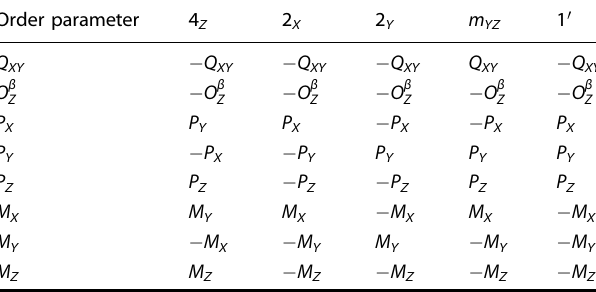
Fig. 7 Conceptual illustration of cross-control of magnetic quadrupole and octupole. a In the case of a hypothetical achiral structure, the antiferromagnetic phase of Pb(TiO)Cu 4 (PO 4 ) 4 would possess only magnetic quadrupoles Q XY . + and − represent the signs of Q XY . The control of the sign of Q XY requires a simultaneous application of electric fi eld E Y and magnetic fi eld H X ( E Y H X ). b , c By introducing the chirality of the crystal structure, which corresponds to the actual structure of Pb(TiO)Cu 4 (PO 4 ) 4 , the magnetic structure acquires additional octupole moments O β . Here, a pair of chiral structures C – ( b ) and C + ( c ) are related to each other by mirror operation m YZ . The signs of O β depend on Z Z or vice versa (see text for details). The signs of Q XY are controllable by those of Q XY . Thus, a switching of the sign of Q XY accompanies that of O β Z (represented by a nonlinear magnetic fi eld H Z H X H X . Accordingly, introducing the chirality allows for an unusual cross-control of Q XY and O β Z with an electric fi eld in a bias magnetic fi eld. thick red and blue arrows); namely, control of Q XY with a magnetic fi eld only and control of O β Z selected by this cross-control is reversed by a switching of the chirality, as experimentally observed. The sign of Q XY and O β Z for the unusual cross-control of Q XY and O β by the E Y H X and Z Table 1. Transformations of various order parameters for Pb(TiO) H Cu 4 (PO 4 ) 4 based on the generators of 4/ mmm point